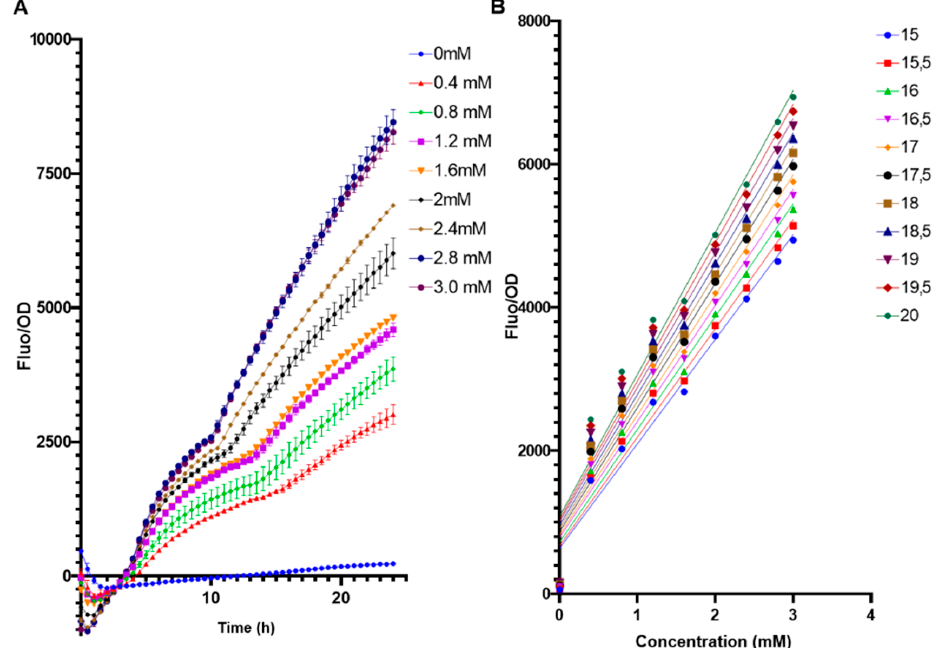
Figure 4. ( A ) Standardized F/OD values of E. coli BL21 pFuc + FucR at different concentrations of fucose for 24 h, in the range of 0–3 mM fucose. All values are presented as average ± SD; n = 3. ( B ) Calibration curves of F/OD vs. fucose concentration for the E. coli BL21 pFuc+ FucR biosensor from 0 mM to 3 mM for 20 h. Numbers on the right indicate time points